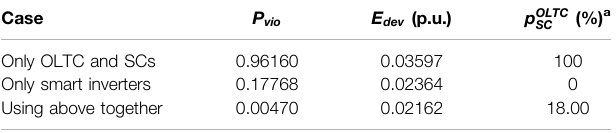
TABLE 2 | Voltage regulation under different cases.